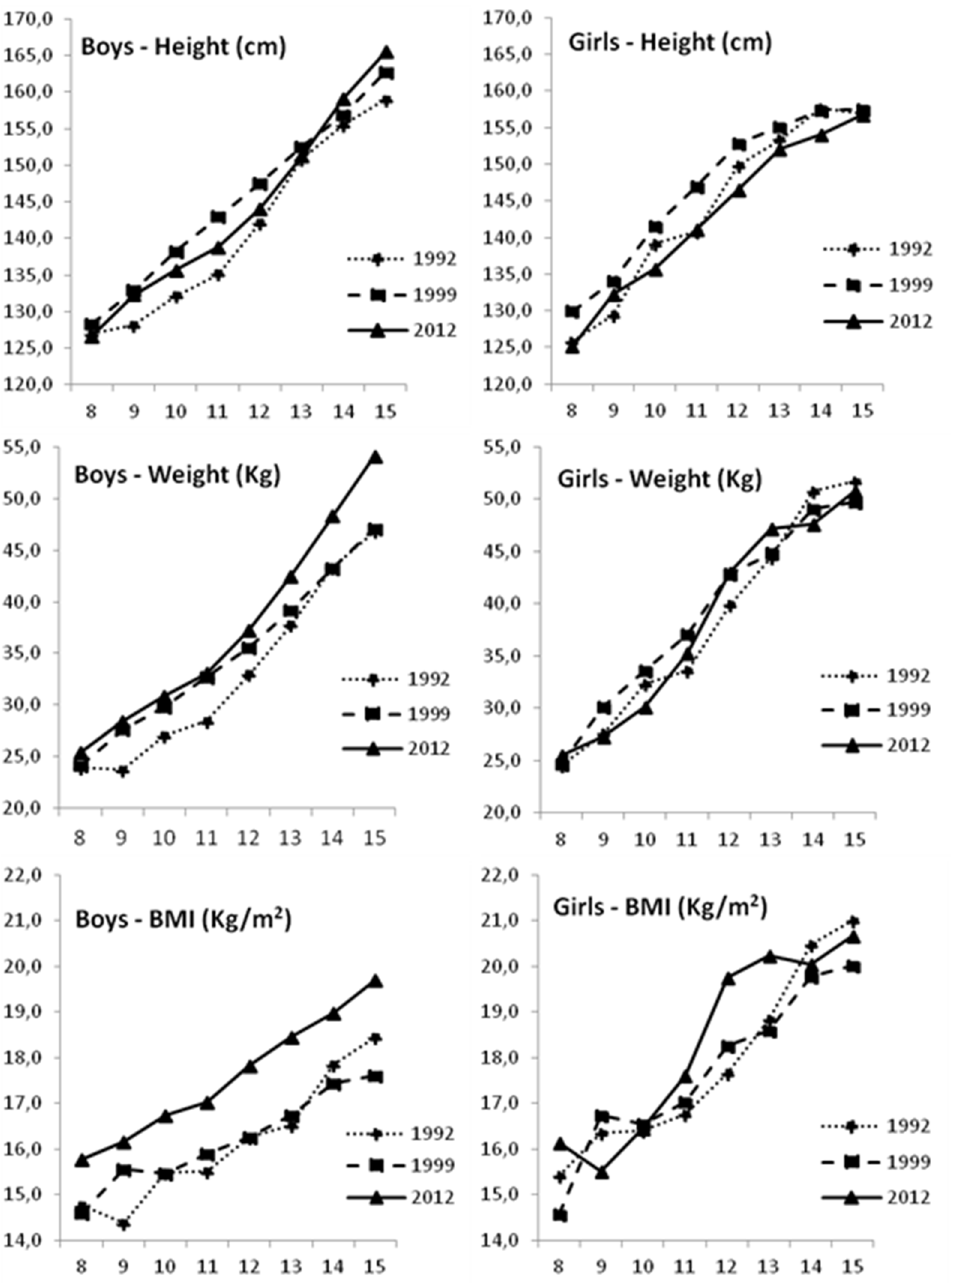
Figure 1. Secular trends for stature, body weight and BMI by age and sex, adjusted for biological maturation (1992, 1999,